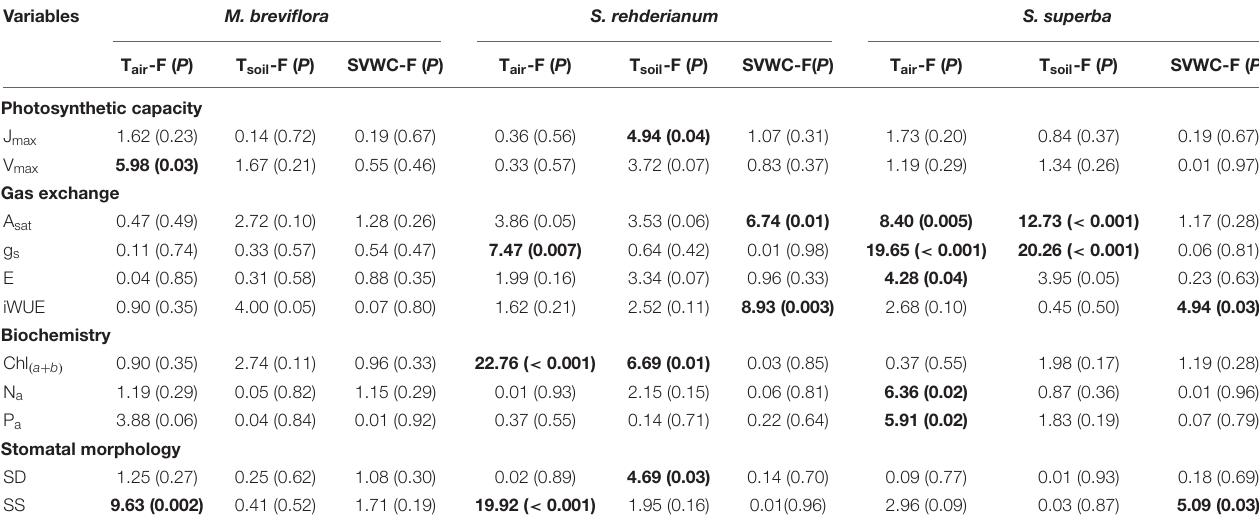
TABLE 3 | Summary report of effects of air temperature (T air , ◦ C), soil temperature (T soil , ◦ C) and soil volumetric water content (SVWC, m 3 m − 3 ) on photosynthetic capacity, gas exchange, biochemistry for Machilus breviflora , Syzygium rehderianum, and Schima superba in last 2 or 3 years under translocation warming by the mixed liner model.